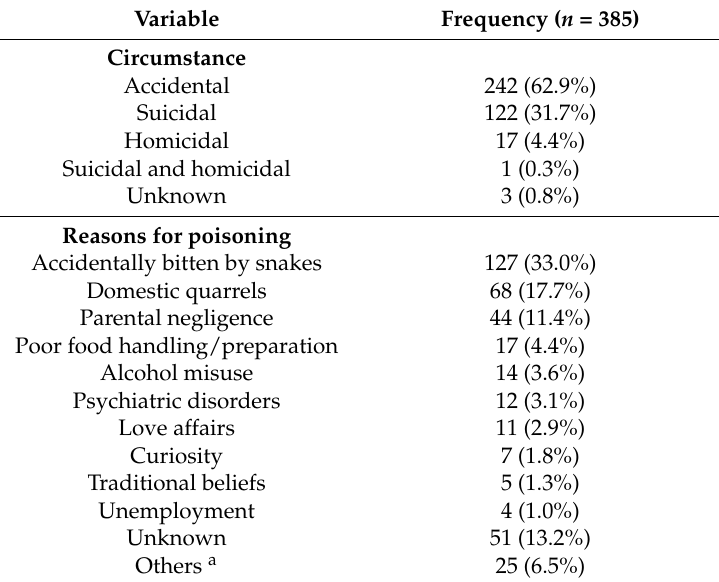
Table 4. Circumstances and reasons for poisoning among victims at JOOTRH.